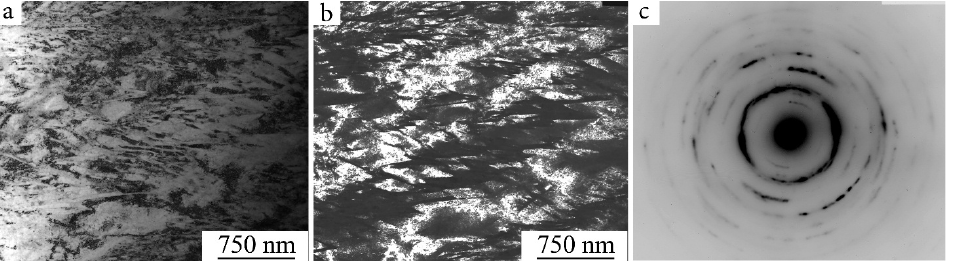
Figure 19. ( a ) Bright- and ( b ) dark-field TEM images of the microstructure, and ( c ) the correspond- ing SAED pattern (SD 1 µm), taken from the Ti 49.5 Ni 50.5 alloy after its MPR by 30%.